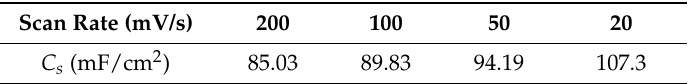
Figure 6. ( a ) Cyclic voltammetry (CV) curve at scanning rates from 20 to 200 mV/s; ( b ) Cycle stability of the micro-SC at a scan rate of 1 V/s. The inset is the CV curves of the 1st, 250th, 750th, and 1000th cycles. Table 1. Specific capacitances at different scan rates.